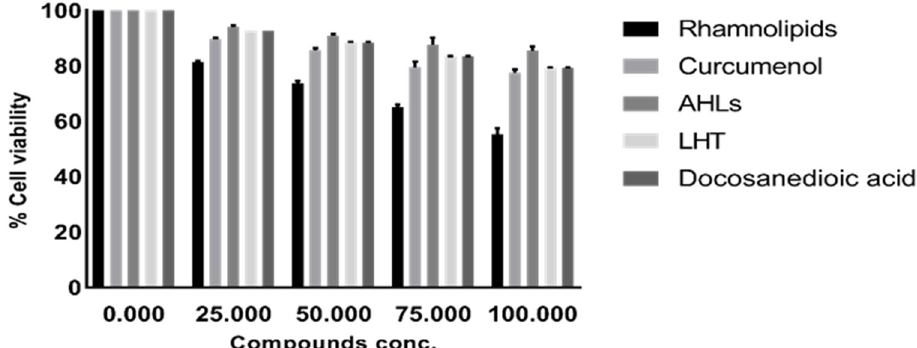
Figure 5. In vitro cytotoxic effects of compounds against HaCaT cell lines. Briefly, pure compounds were incubated with HaCaT cells monolayer in a 96 well plate at 37 °C for 24 h in the presence of 5% CO 2 and humidified conditions. Following day, LDH released by cells was measured at 490 nm and results were recorded. ( a ) Pure compounds tested were non-toxic against HaCaT cells. ( b ) Representative images and compounds effects incubated with cell monolayer.